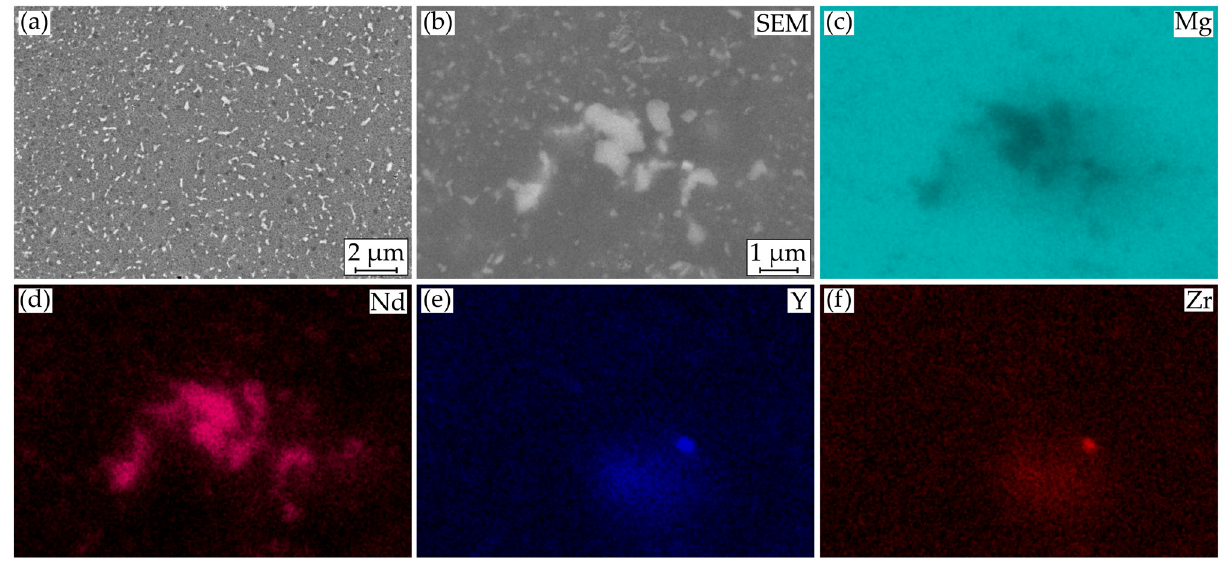
Figure 2. ( a , b ) Cross-sectional microstructure of WE43 with EDS mappings of ( c ) magnesium (Mg), ( d ) neodymium (Nd), ( e ) yttrium (Y), and ( f ) zirconium (Zr). Investigations performed with a focused ion beam scanning electron microscope (FIB-SEM, Crossbeam XB 550L, Carl Zeiss AG, Oberkochen, Germany).